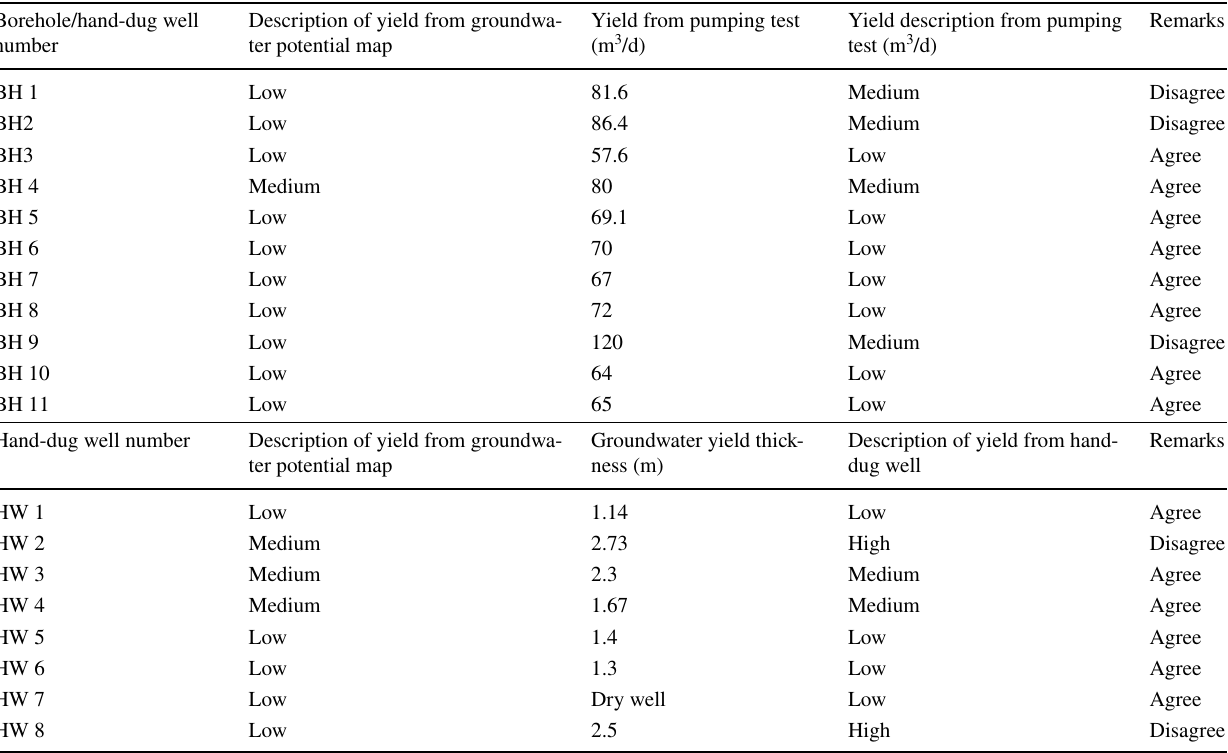
Description of yield from groundwa- ter potential map